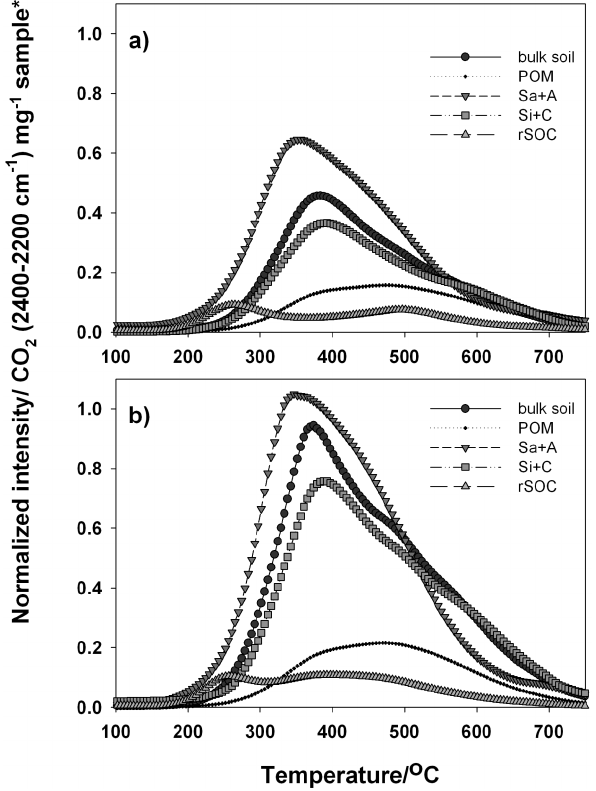
Figure 8 Fig. 7. FTIR-EGA CO 2 thermograms of bulk soil and fractions heating from 25 to 700 ◦ C at 68 ◦ Cmin − 1 under synthetic air purge from the (a) Kraichgua and (b) Swabian Alb sites. Bulk soil < 2mm, POM-sand fraction < 1.8gcm − 3 fraction diluted 1 : 50 sand fraction > 1.8gcm − 3 , silt + clay < 63µm, rSOC < 63µm